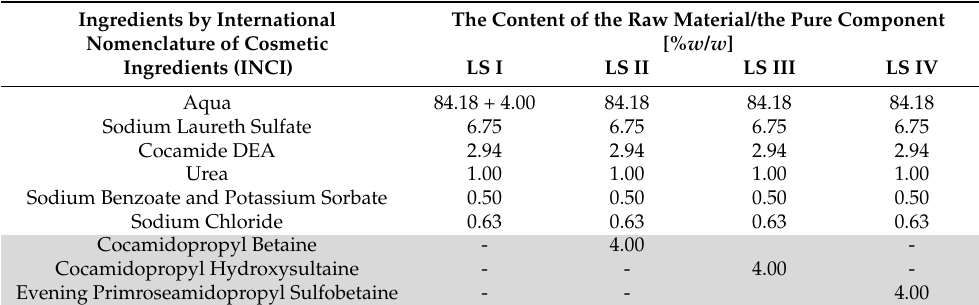
Table 2. The proportion of ingredients used for the production of new